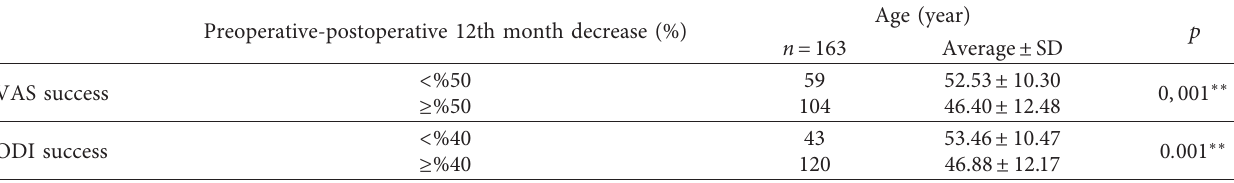
Figure 3: . ODI values were taken during 12 months preoperatively and postoperatively. ∗ : statistically significant compared to preoperative values ( p < 0 , 01 ) . # : statistically significant compared to postoperative 2nd week ( p < 0 . 01 ) . Friedman test and Wilcoxon signed ranks test, p < 0 . 01. Table 3: Evaluation of success and age relation.